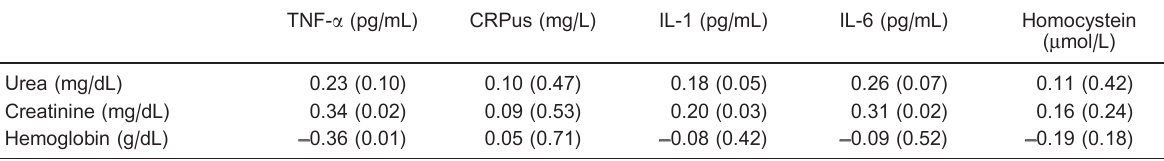
Table 4. Logistic regression model between cytokines and biochemical markers in community-acquired pneumonia